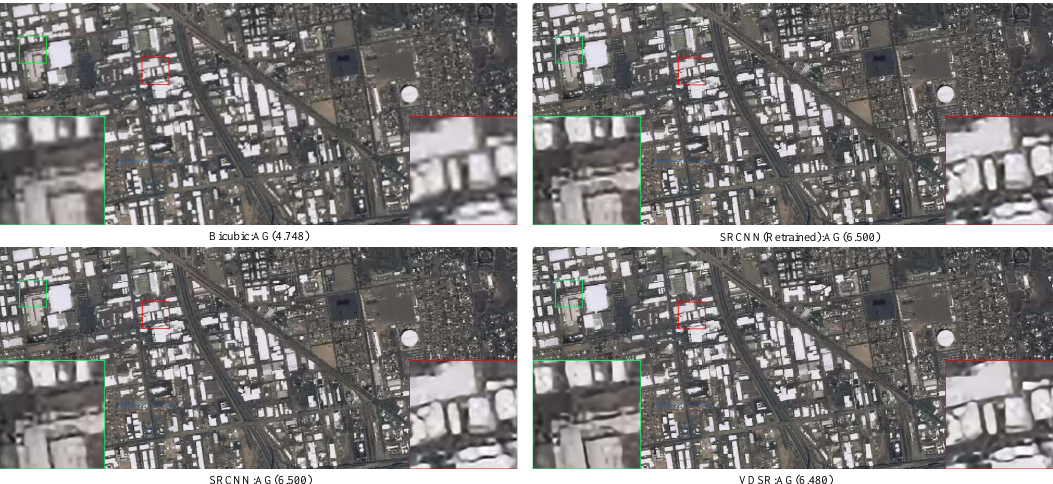
Figure 10. The reconstruction results on Jilin-1 dataset with the scale of 4. We select several different but representative scenarios, i.e., aircraft carrier, city suburb, and military harbour to make comparisons. Red and blue indicate the best and the second best performance, respectively.